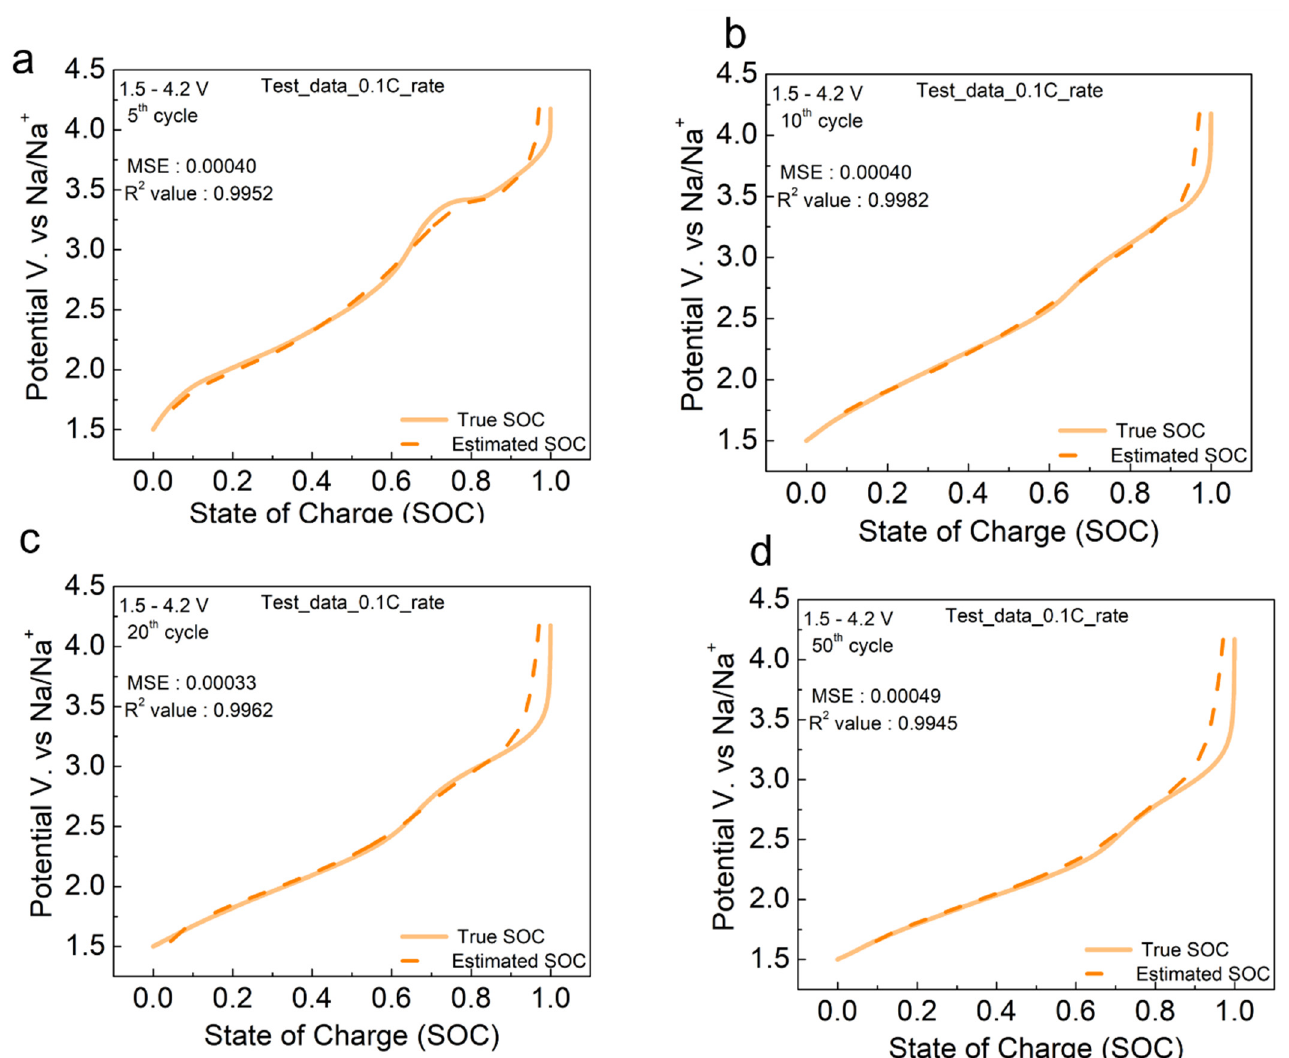
Figure 7. Performance of the FNN model, shown using voltage vs. State of charge graph rate by comparing the true and estimated values. Data used were from the battery discharged between 1.5–4.2 V vs. Na/Na + at a 0.1 C rate for the ( a ) 5th cycle, ( b ) 10th cycle, ( c ) 20th cycle, and ( d ) 50th cycle. Mean square value and R 2 value are mentioned on each graph.